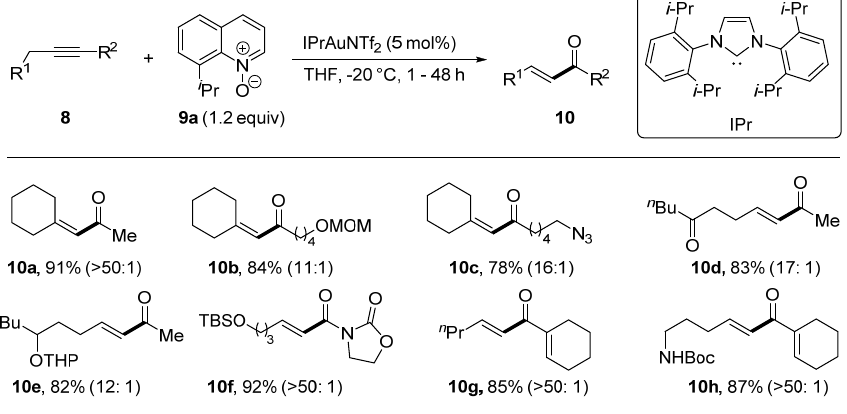
Scheme 6. Synthesis of α , β -unsaturated carbonyls 10